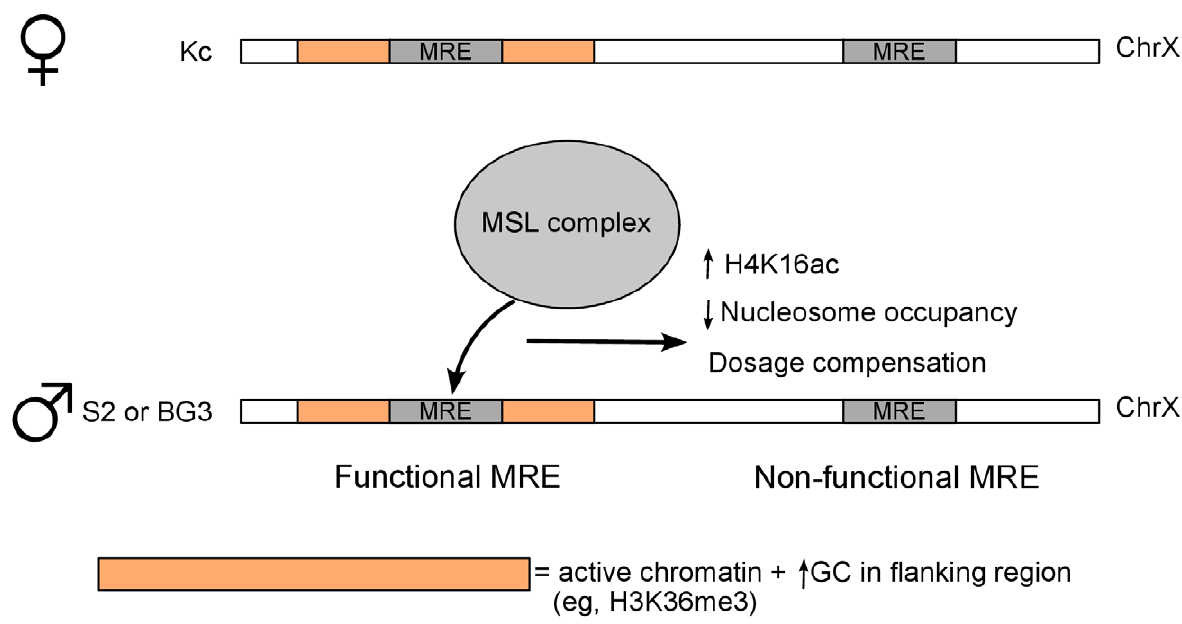
Figure 7. Model for binding site selection by a chromatin associated factor. Our results support roles for local chromatin environment and flanking GC content in discrimination of true target sites of the MSL dosage compensation complex. The model depicts the GC content and active chromatin marks surrounding MREs in female Kc cells that predict binding by MSL complex in male S2 or BG3 cells (or after MSL induction in female Kc cells). MREs that do not pre-exist in a favorable environment are not bound by MSL complex and thus are non-functional. Definition of the favorable chromatin features that pre-exist factor binding may be a general tool, in addition to DNA motif analysis, for prediction of functional binding